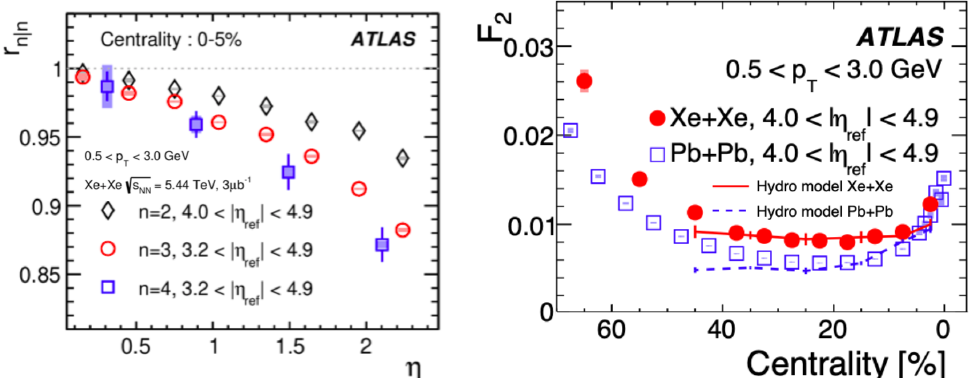
Figure 2: Left panel: r , r and r as a function of η in Xe + Xe collisions for 2 | 2 3 | 3 4 | 4 | stands between 4.0 < | η | < 4.9 for r six centrality intervals. The | η , and ref ref 2 | 2 | < 4.9 for r 3.2 < | η and r . The error bars and boxes regard statistical and sys- ref 3 | 3 4 | 4 tematic uncertainties, respectively. Right panel: The F compared between Xe + Xe 2 and Pb + Pb collisions as a function of centrality. The error bars and shaded boxes on the data represent statistical and systematic uncertainties, respectively [ 8 ] . The results from a hydrodynamic model are shown as solid lines (Xe + Xe) and dashed lines (Pb + Pb) with the vertical error bars representing statistical uncertainty of the predictions [ 9 ]